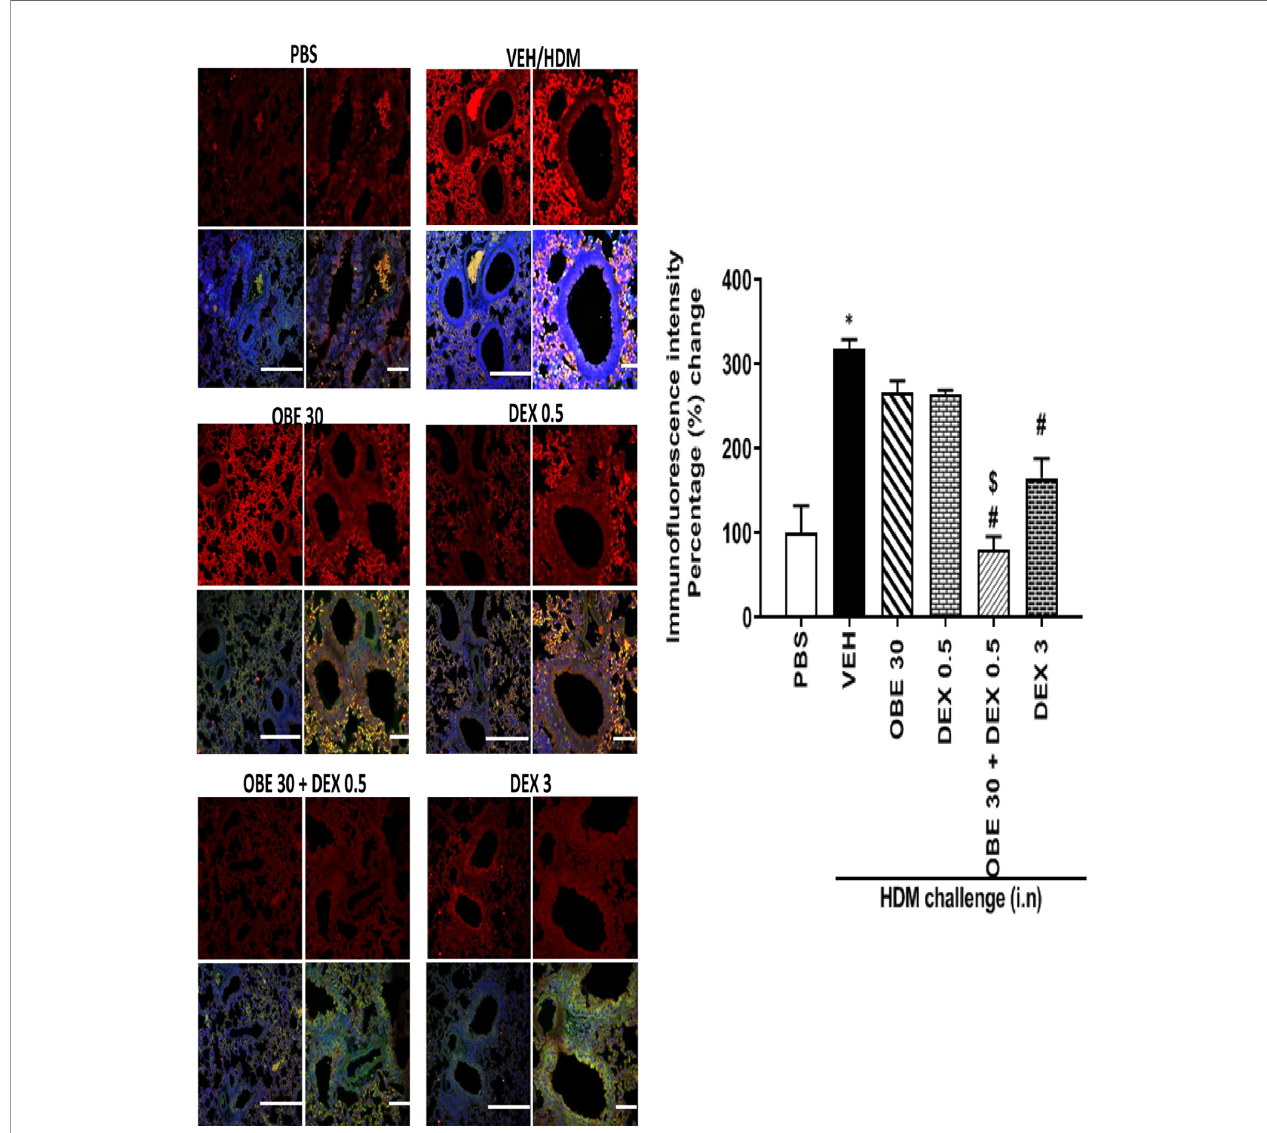
FIGURE 12 | Immuno fl uorescence (Alexa Fluor) detection of phosphorylated ERK1/2 are shown in the upper panels overlaid with DAPI stain on the lower panel to show lung tissue architecture. Lung sections were taken from different treatment groups, control PBS-challenged mice (PBS), HDM-challenged mice (HDM), HDM- challenged mice pretreated with OBE (30 mg/kg; i.p.) (OBE 30), HDM-challenged mice pretreated with low dose dexamethasone (0.5 mg/kg; i.p.) (DEX 0.5), HDM- challenged mice pretreated with a combination of OBE (30 mg/kg; i.p.) and low dose dexamethasone (0.5 mg/kg; i.p.) (OBE 30 + DEX 0.5), HDM-challenged mice pretreated with high dose dexamethasone (3 mg/kg; i.p.) (DEX 3), scale bar = 50 µm. Graph shows quantitative assessment of fl uorescence intensity of ERK (arbitrary units). Data are expressed as mean ± SEM ( n = 4 – 5). *P < 0.05 vs PBS and # P < 0.05 vs HDM and $ P < 0.05 versus either OBE (30 mg/kg; i.p.) alone group or dexamethasone (0.5 mg/kg/i.p.) alone